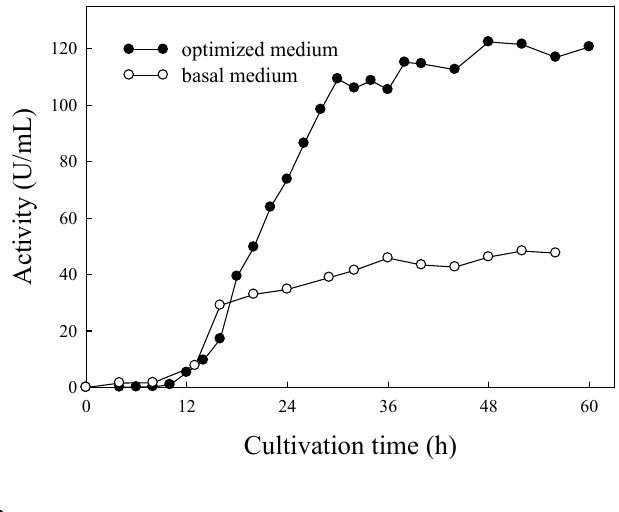
Figure 4. Lipase production by Burkholderia sp. in basal and optimized media.